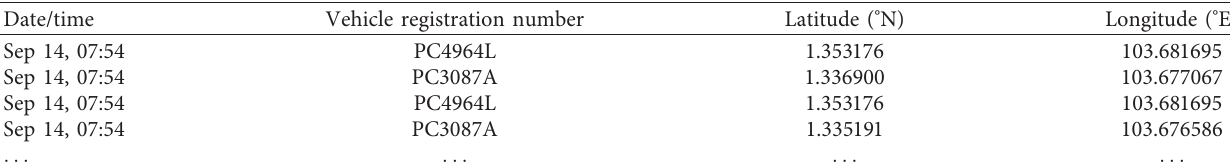
Table 7: Data filtering.